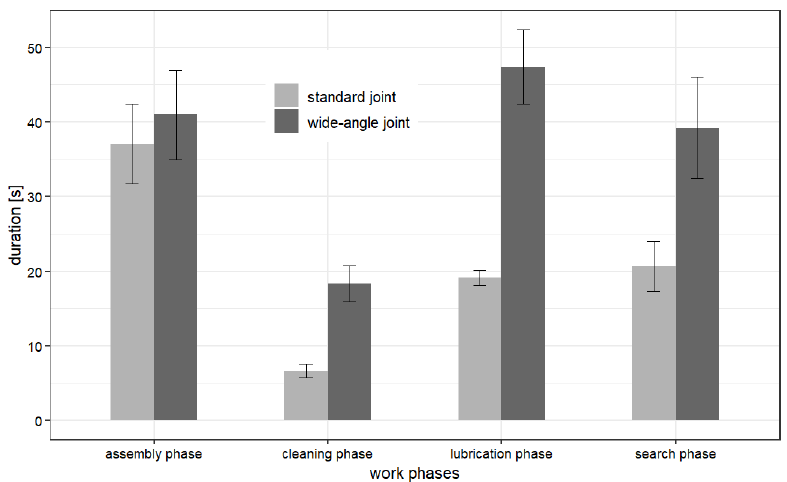
Figure 4. Mean values of the work phases by PTO shaft type, with standard